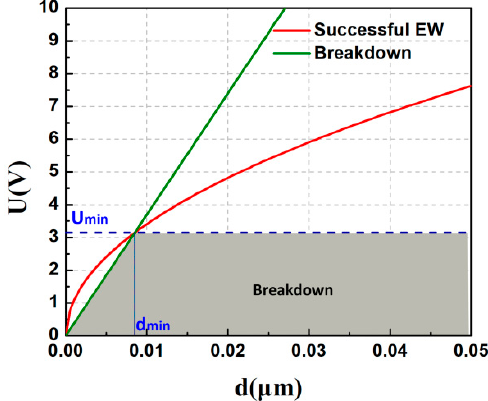
Figure 11. Effective electrowetting and dielectric breakdown voltage versus insulator thickness. Green solid line: critical voltage for dielectric breakdown (for EBD = 370 V/ µ m). Red solid line: voltage required for a contact angle decrease from 120 ◦ –60 ◦ (for γ LV = 0.0728 N/m between water and air; ε = 13). The dashed line indicates the minimum applied voltage and insulator thickness.